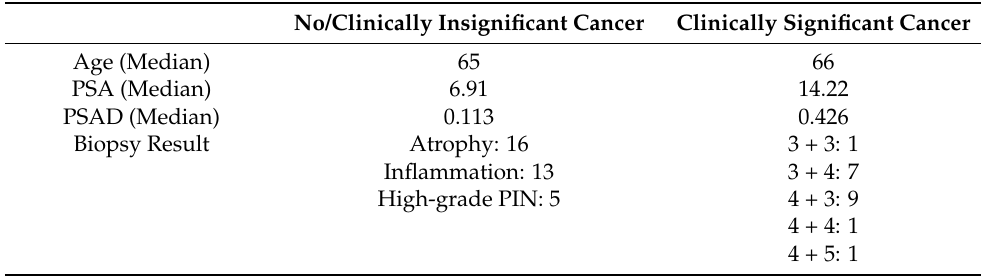
Table 1. Clinical and pathological information of 38 patients included in the study (19 with no/clinically insignificant cancer and 19 with clinically significant cancer). The median age and PSA/PSAD results for each cohort are presented, along with the biopsy results/Gleason scores. The false positive patient cohort had combinations of the three disease types